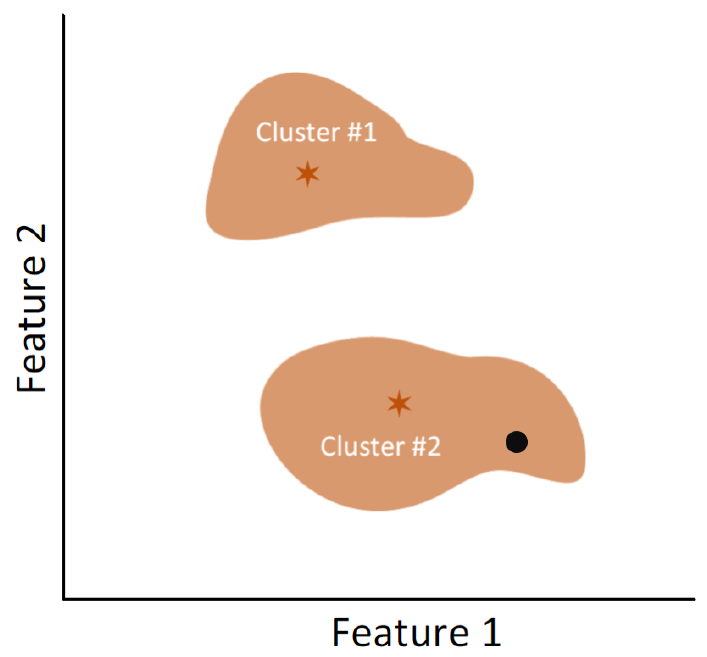
Figure 2. Example of k-means technique performance for two